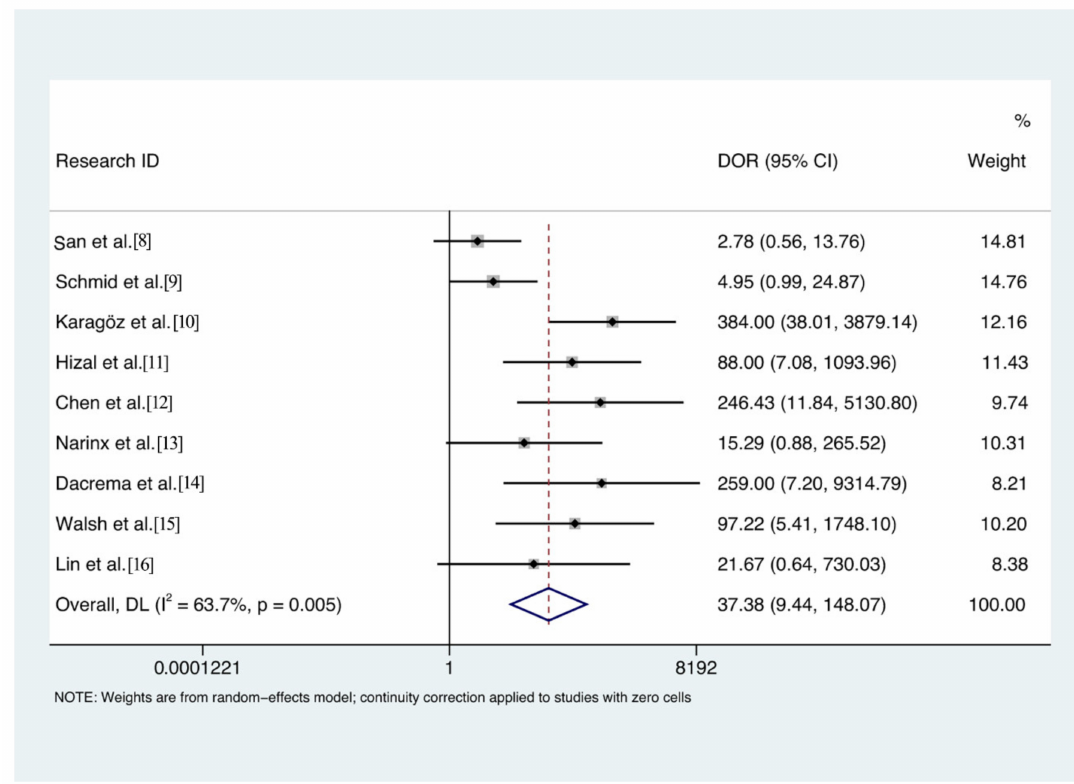
Figure 4. Diagnostic odds ratio of lung ultrasound for the diagnosis of interstitial pneumonia caused by COVID-19.